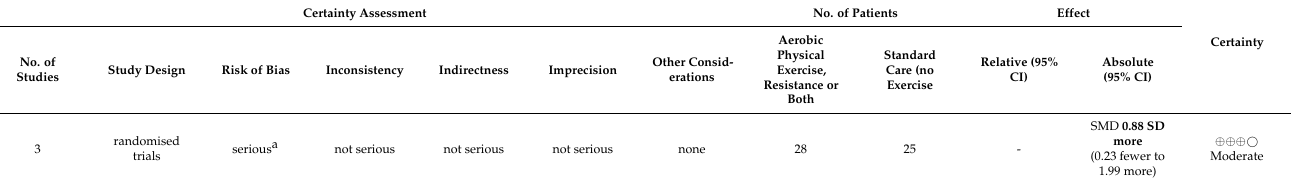
Figure 8. Forest plot of the quality of life total score [15,16,18]. Table 4. Quality of evidence for the quality of life total